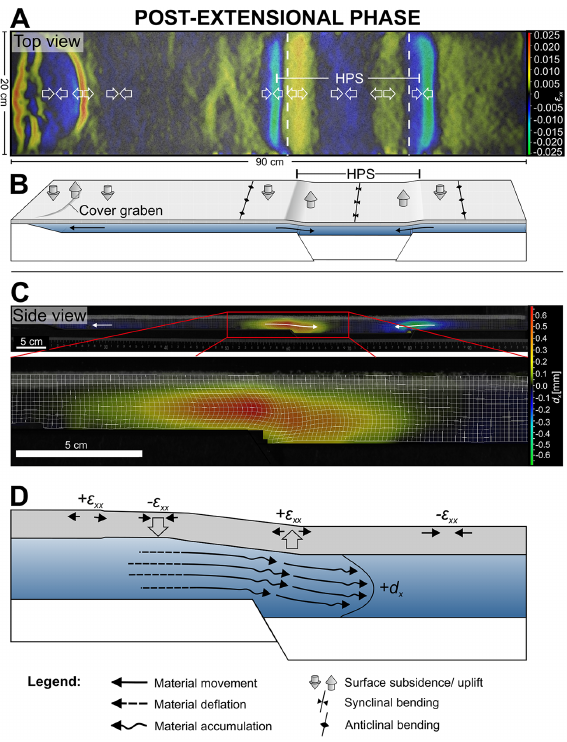
Figure 7. Results of PIV monitoring during the post-extensional phase of the reference experiments 1b and Exp. 1c 15min after basement extension had ceased. (a) Top view of Exp. 1c: lateral strain ε xx observed with PIV displaying zones of extension (yel- low) and zones of compression (blue). Dashed lines indicate loca- tion of basal faults. HPS = hanging wall peripheral sink. (b) Sketch showing the interpretation of the PIV strain patterns. (c) Side view of Exp. 1b: horizontal displacement d x observed with PIV includ- ing a detailed view of the left basement fault. Coloured areas dis- play rightward (yellow–red) and leftward (green–blue) movement of the analogue material. (d) Conceptual sketch (arrows are not to scale) summarizing the interpreted displacement patterns and show- ing representative vector profiles of the material movement.